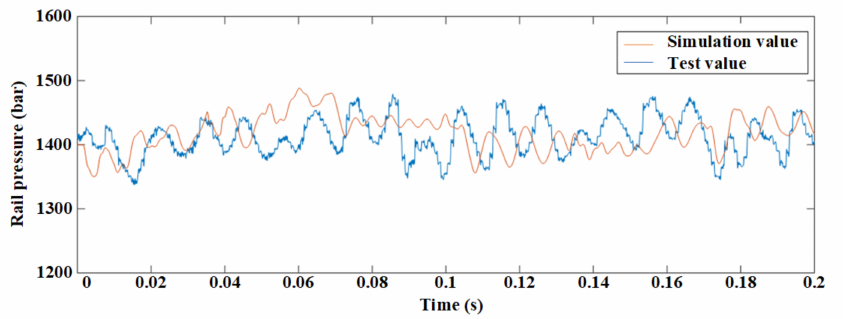
Figure 6. Verification of common rail pressure